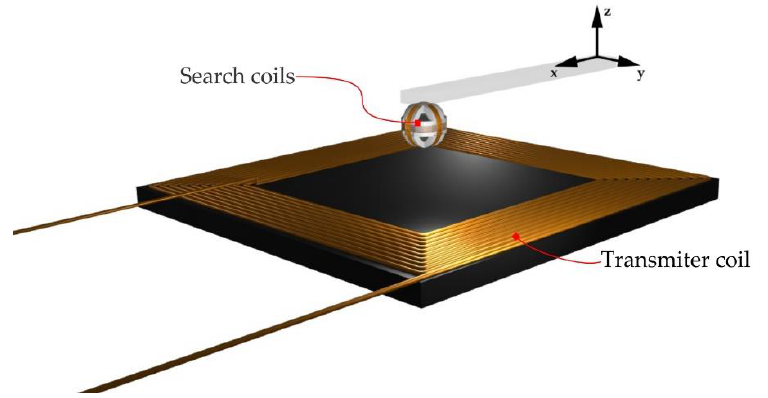
Figure 3. Transmitter coil and 3D search coil.